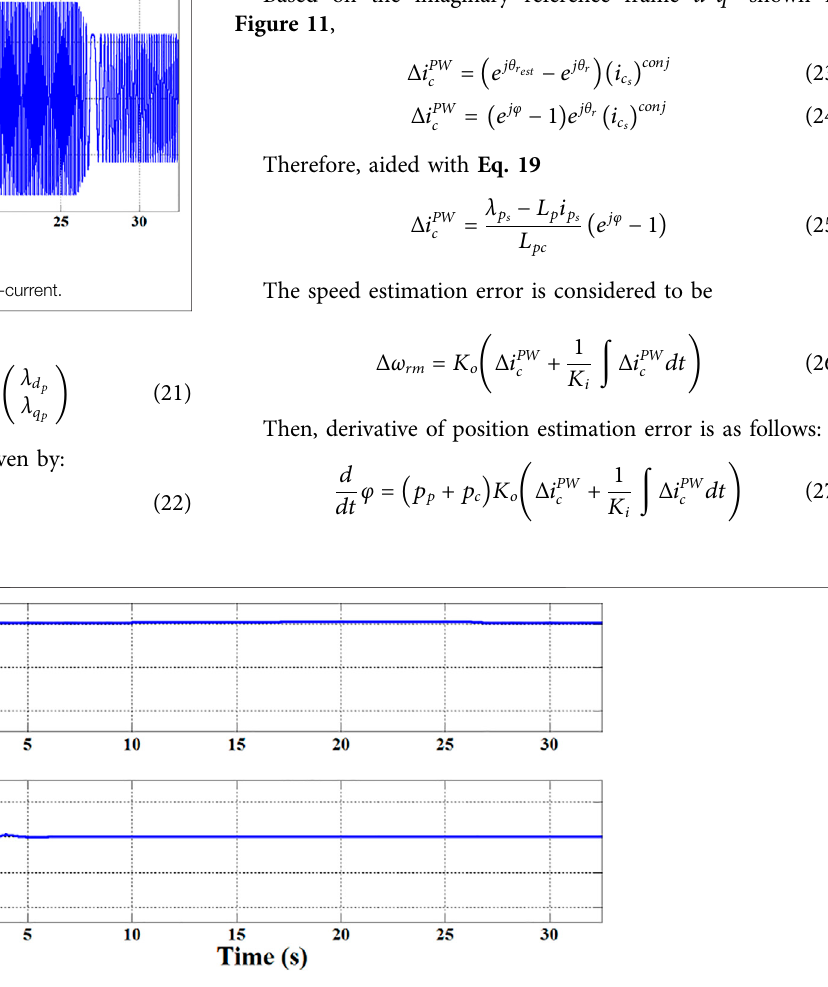
FIGURE 13 | Response of the dq-axis power-winding fl ux